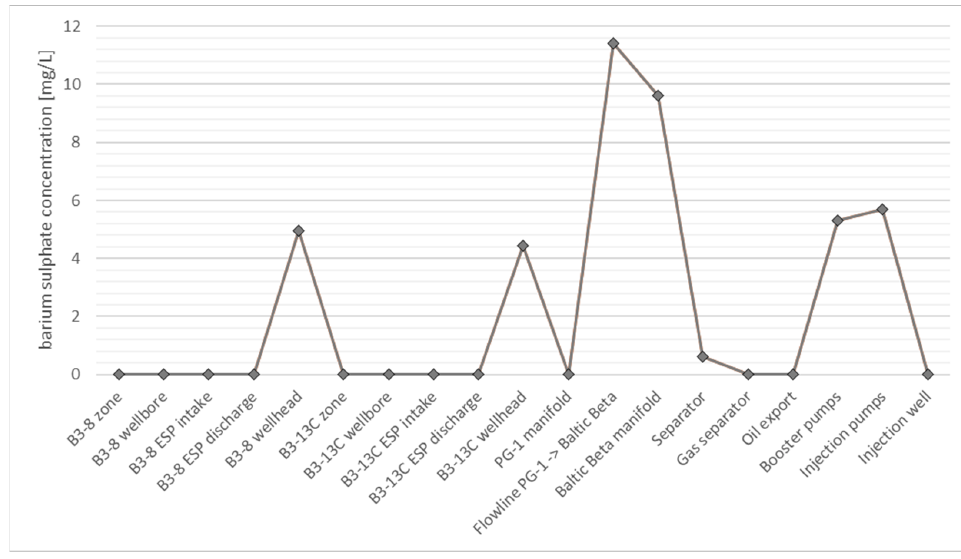
Figure 5. Possible barite concentration in different critical points of the installation.